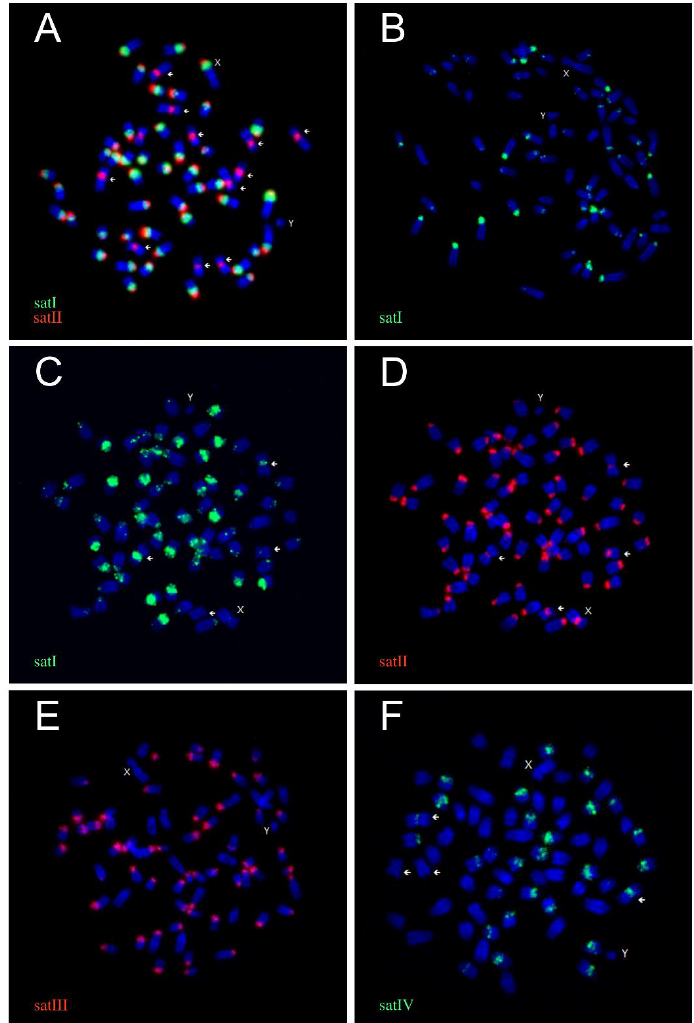
Figure 1. Examples of the fluorescence in situ hybridisation (FISH) patterns of satI-IV probes in Cervidae. ( A ) SatI (green) and satII (red) probes in Rucervus eldii (Cervini). ( B ) SatI (green) probe in Capreolus capreolus (Capreolini). ( C ) SatI (green) probe in Alces alces (Capreolini). ( D ) SatII (red) probe in A. alces . ( E ) SatIII probe (green) in C. capreolus . ( F ) SatIV probe (green) in A. alces . Arrows indicate metaphase chromosomes.